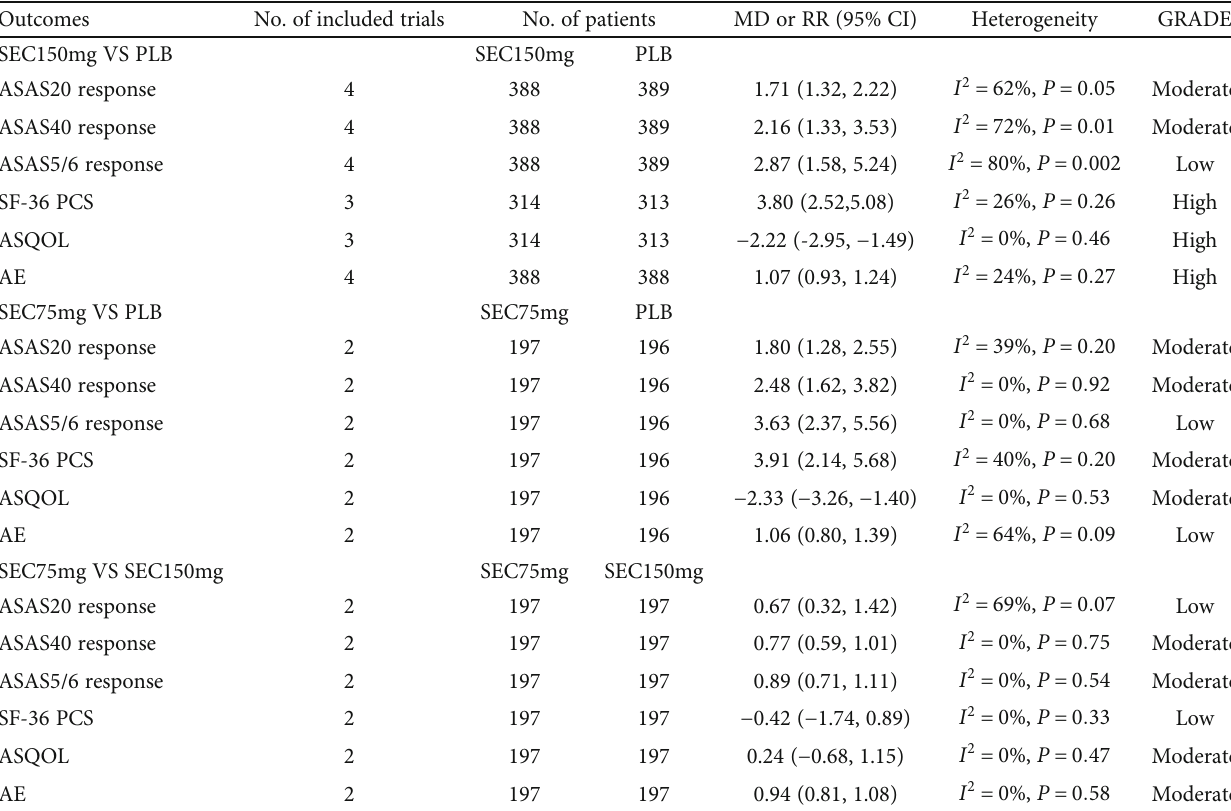
Table 2: The GRADE evidence quality for each